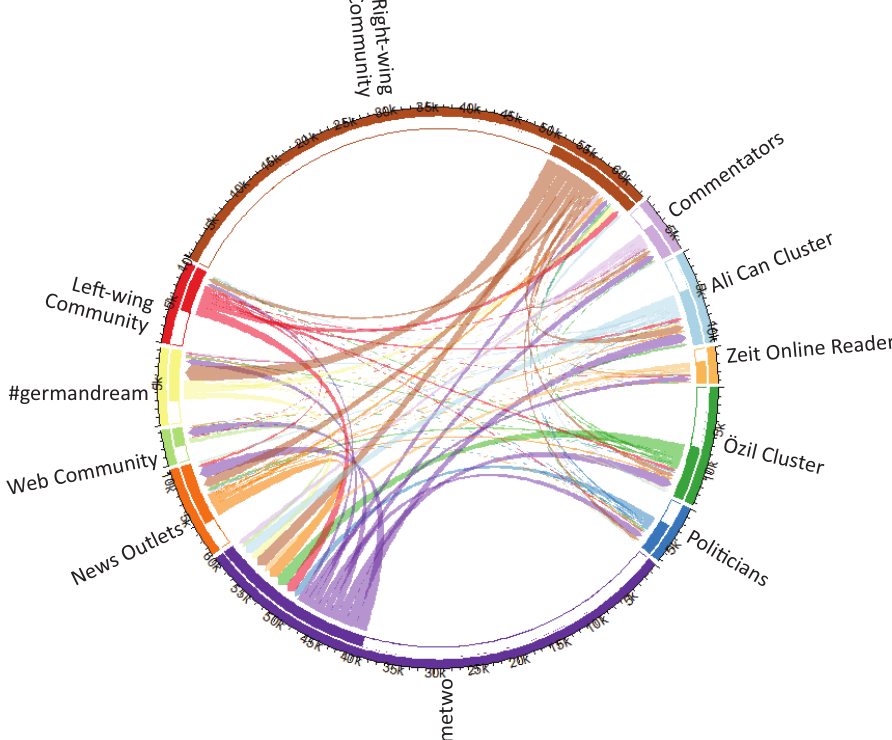
Figure 3. Community interaction in absolute numbers of tweets in thousands. White area indicates the share of interaction within communities. Visualization via circlize (Gu, Gu, Eils, Schlesner, & Brors, 2014).